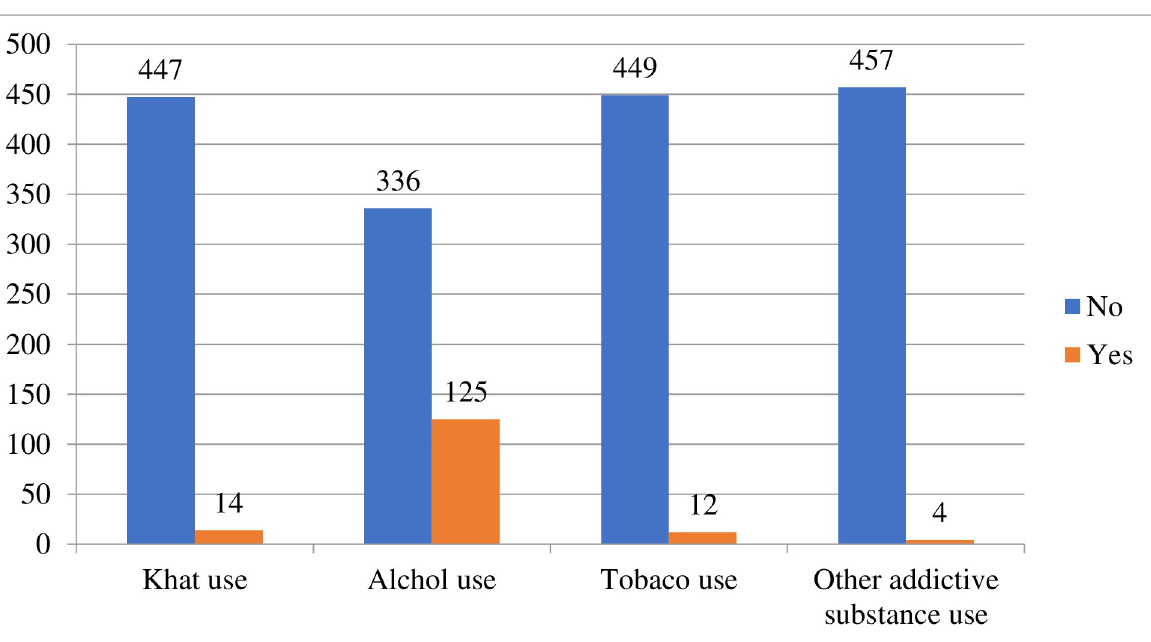
PLOS ONE | https://doi.org/10.1371/journal.pone.0275120 September 28,